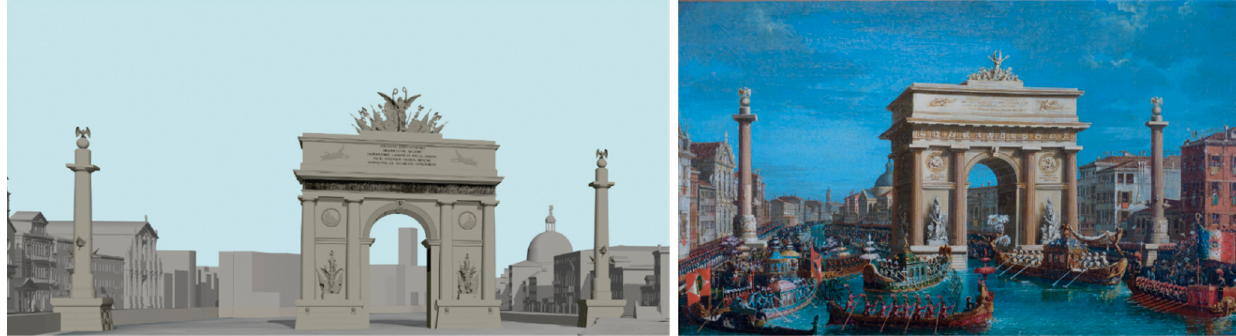
Figure 17. Comparison between Borsato’s painting depicted in 1809 and the view on the model obtained from the grip center calculated by SfM algorithms.